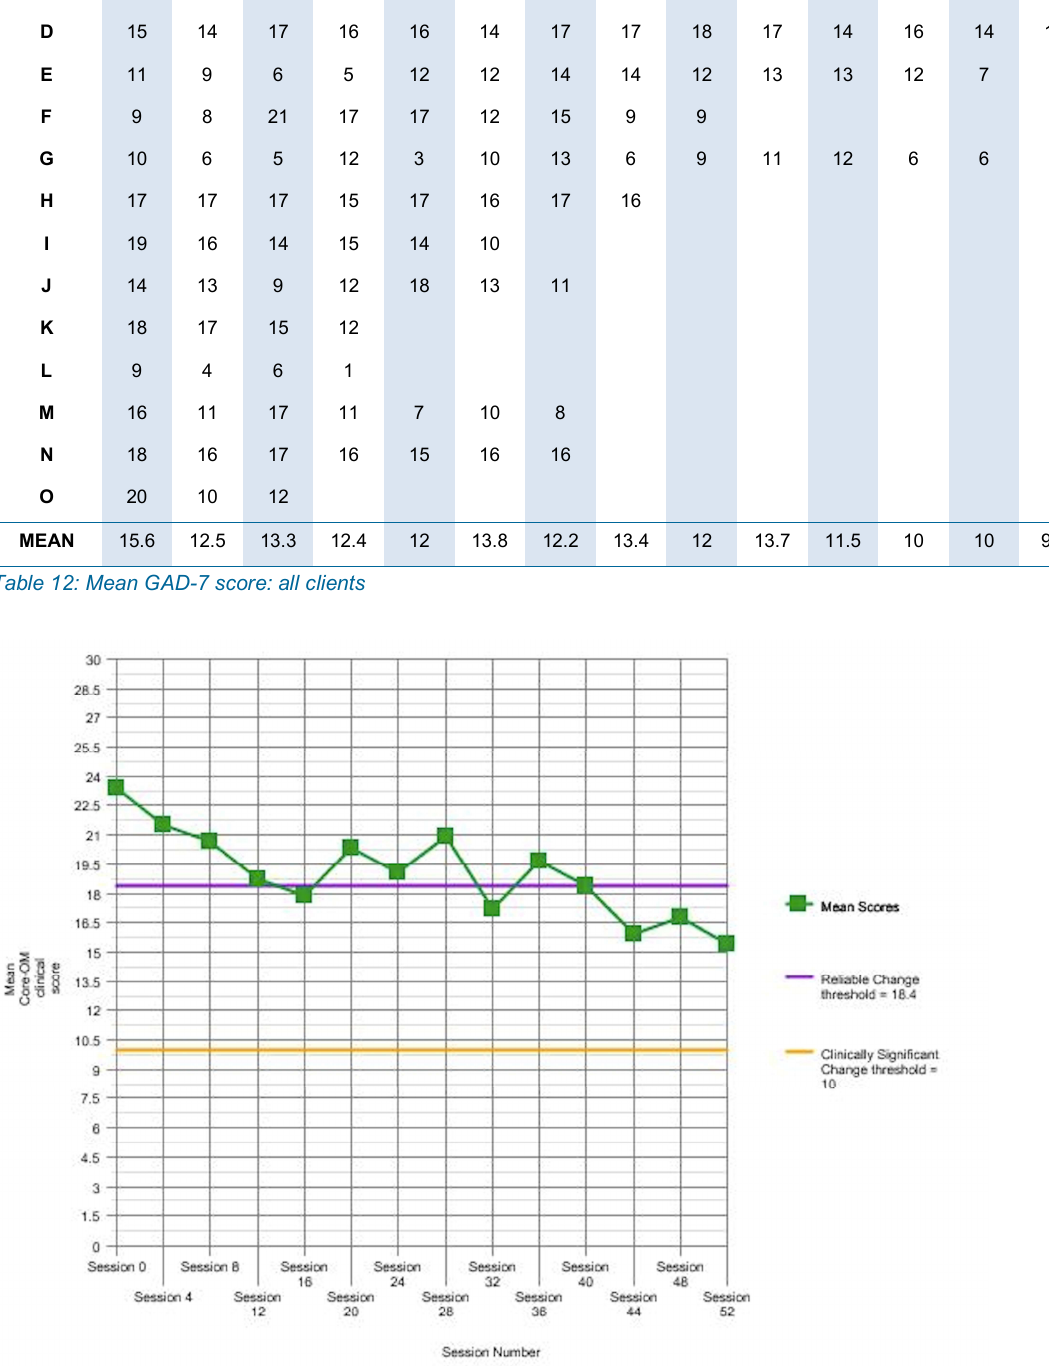
Figure 7: Mean Clinical CORE OM Score: all